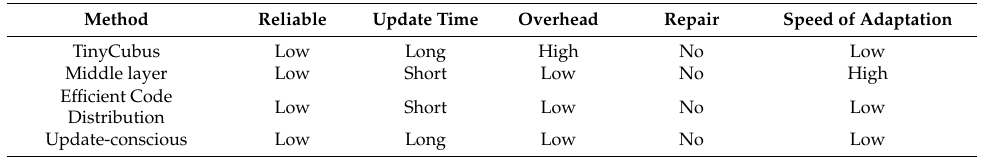
Table 4 summarizes classifications and comparisons of minor updated in WSNs. Table 4. Classification of minor updates in